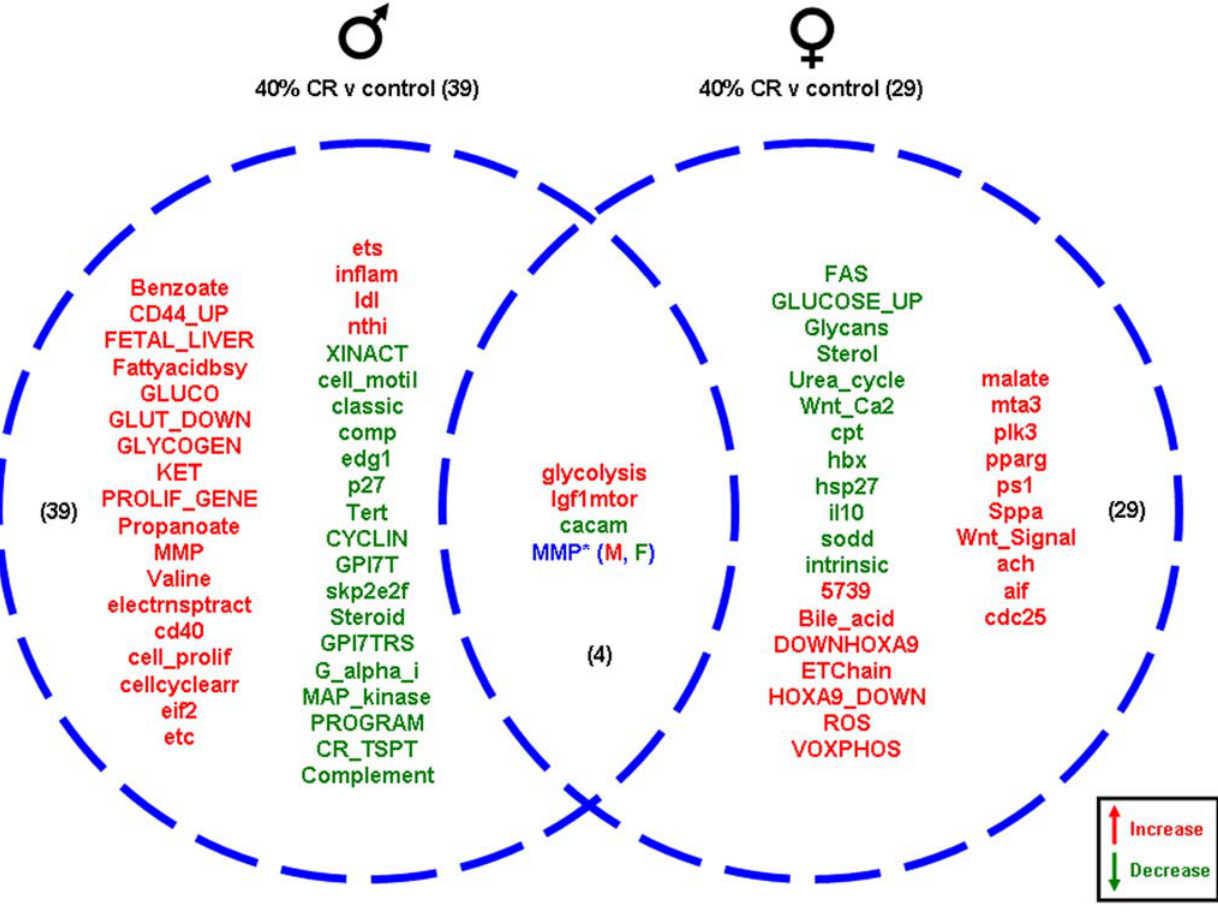
Figure 10. Pathway changes in the gonads of male and female rats maintained on the 40% CR diet compared to the gonads of male and female rats maintained on the control ( adlibitum ) diet. Significantly regulated, functional pathway clusters were generated from the respective male or female gene sets using PAGE gene set analysis. Pathways that were significantly up-regulated (red) or down-regulated (green) were clustered into a Venn diagram. Pathways in blue were common to both males (M) and females (F) but were differentially regulated. Names of the significantly altered pathways can be found in Table S2.